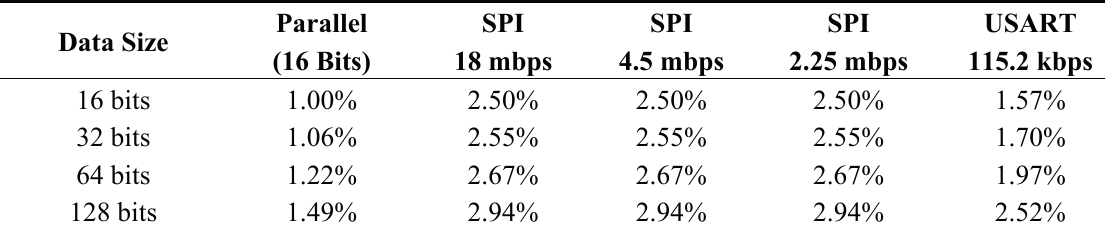
Table 7. Energy Intrusion (%) per